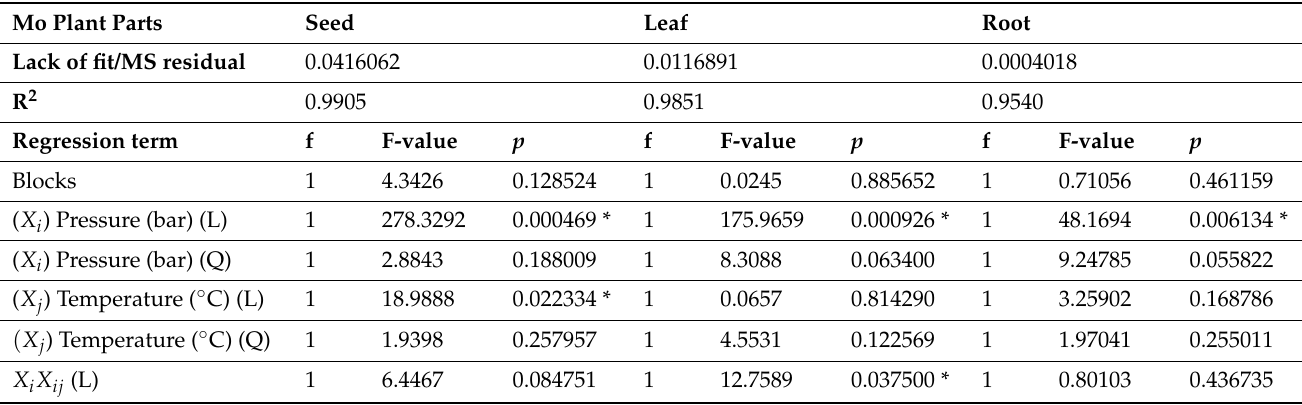
Table 2. Significant effects on SFE-CO 2 experiments by ANOVA ( α = 0.05) for Mo seed, leaf, and root SFE-CO 2